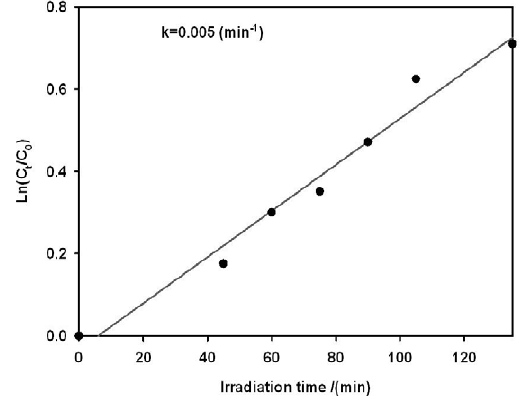
Fig. 10. Relative degradation of RR4 in the presence of iron oxide nanoparticles under UV light irradiation. Fig. 11. The kinetic plot of photocatalytic degradation of